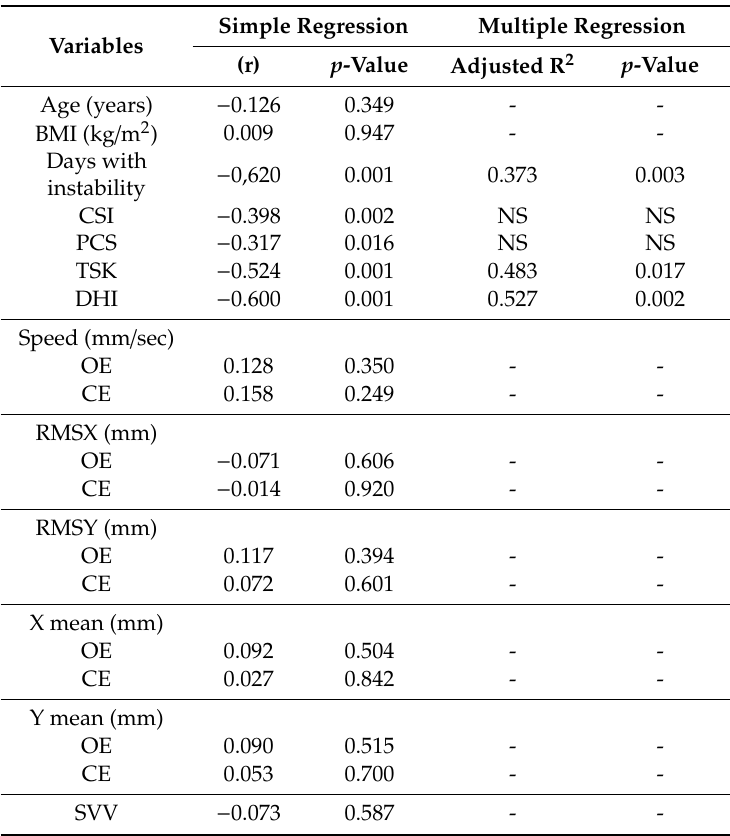
Table 4. Simple and multiple linear regression to predict ABC